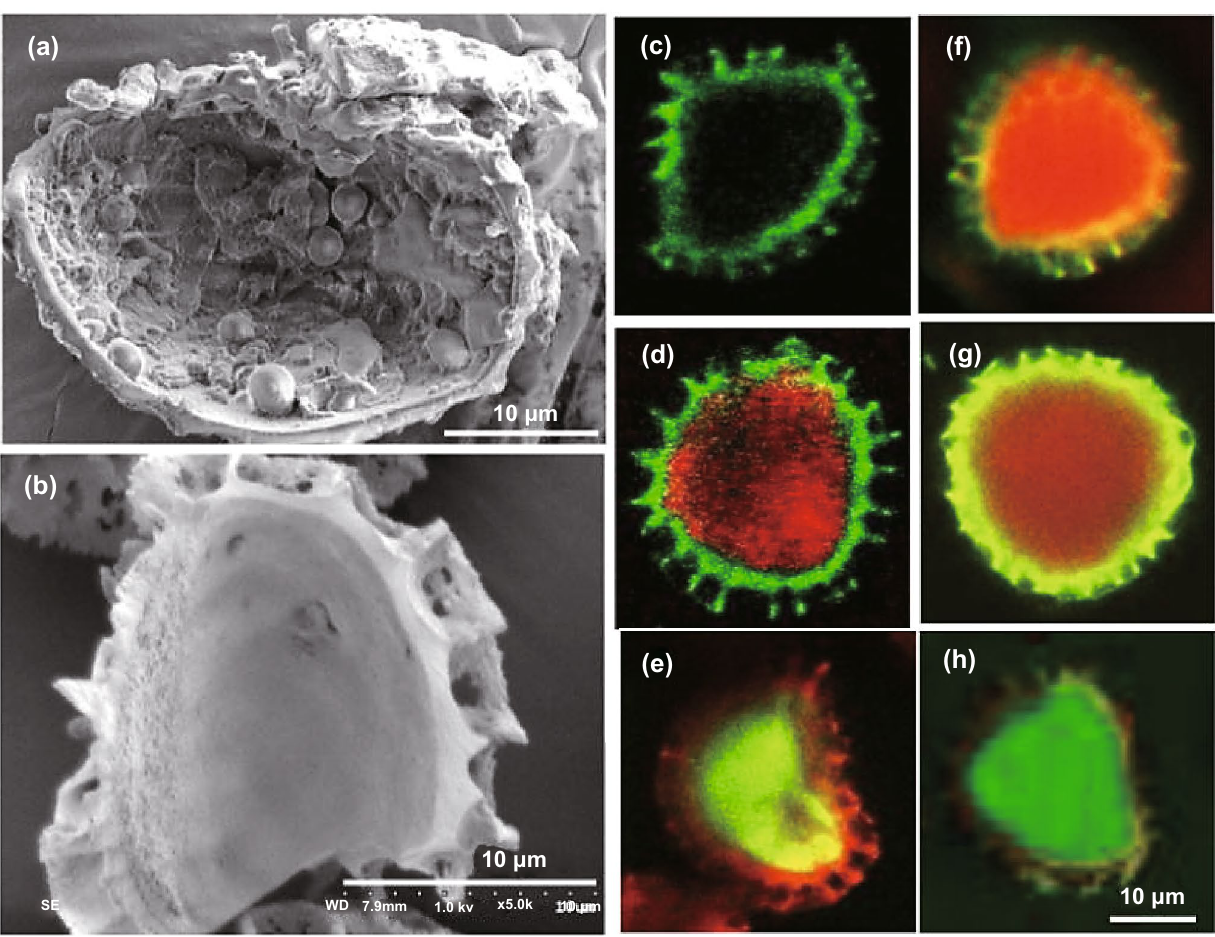
Fig. 7 SEM images of lycopodium spores manually cracked ( a ) biomolecules and cellular organelle are observed in the core before process- ing, and ( b ) a clear core can be observed after chemical processing. The chemical processing of lycopodium spores with their confocal images, empty (c) , loaded with sulforhodamine ( d) , loaded with dextran conjugated to fluorescein isothiocyanate ( e) , loaded with ovalbumin conjugated to texas red ( f ), loaded with bovine serum albumin conjugated to texas red ( g ), and loaded with dextran conjugated to fluorescein isothiocyanate ( h ). Reproduced with permission from Ref. [46]. (Color figure